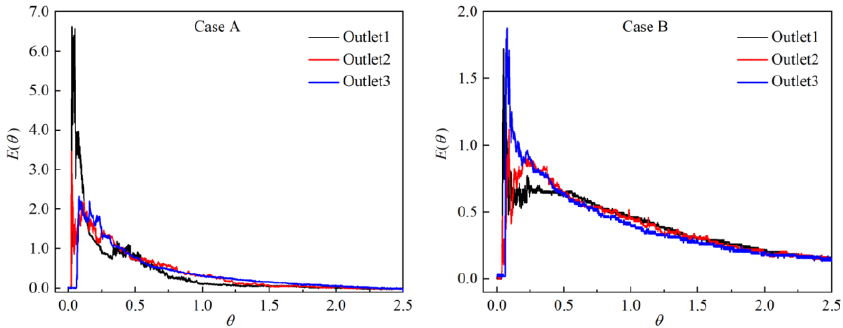
Figure 3. Comparison of RTD curves between cases A and B.